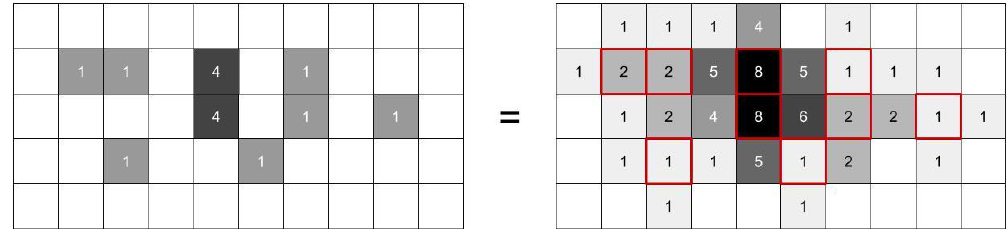
Figure 3. Moving Window Analysis. Darker cells represent “raw” data position (e.g., a cell containing canopy) on a surface of null values. The grid on the right displays the output of a 3 by 3 meter ‘+’-shaped moving window analysis performing a summation function. Original pixel locations are highlighted in red for comparison.